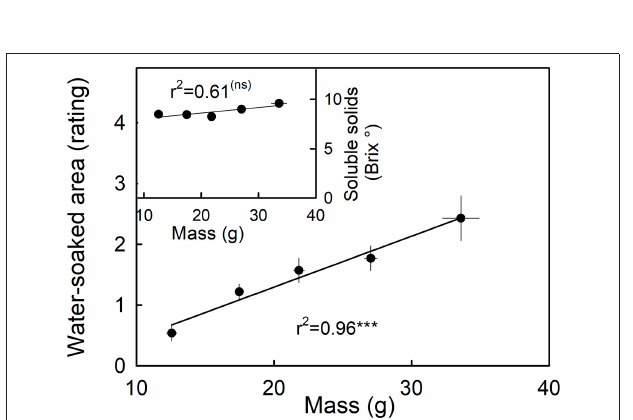
FIGURE 7 | (A) Effect of ripening stage (as indexed by hue angle) on the water-soaked area when strawberries are incubated in deionized water. (B) Relationship between the water-soaked area and water uptake. Inset: Uptake vs. osmotic potential. Water soaking was indexed using a 5-point rating scale: score 0, no water soaking; score 1, < 10% of the surface area water-soaked; score 2, 10–35%; score 3, 35–60%; score 4 > 60%.